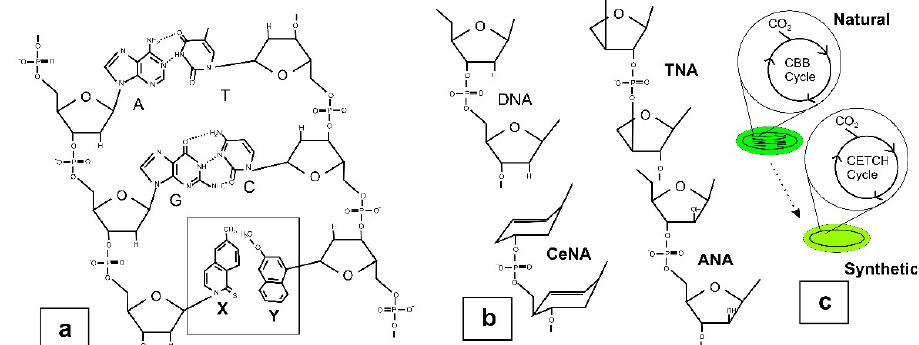
Figure 6. Some examples of possible studies in the synthetic-xenobiology: (a) implementation of uncommon base pairs (A = adenine; T = thymine; G = guanine; C = cytosine; and the synthetic bases: X = d5SICS; Y = dNaM), (b) engineering the uncommon sugar backbone for XNA (DNA = deoxyribose nucleic acid, the natural nucleic acid involved in heredity; and the synthetic sugar backbones: TNA = threose nucleic acid; CeNA = cyclohexitol nucleic acid; ANA = arabinose nucleic acid), and (c) creation of foreign biosynthetic pathway. The base structure in (a) is inspired by Galindo-Murillo and Barroso- Flores (2017), (b) is by Pinheiro et al . (2012), and (c) by Miller et al .